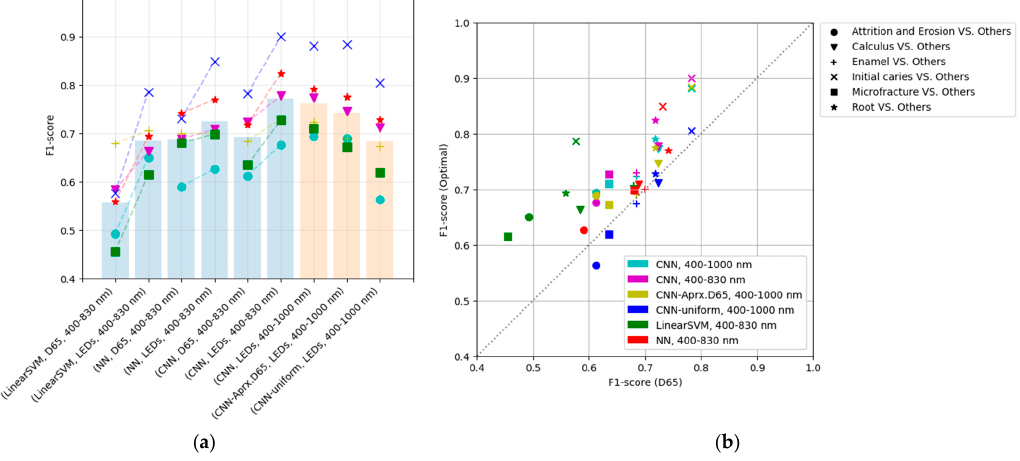
Figure 12. The performance of each method of the band-aligned SPD utilizing the NIR in the 400–1000 nm band with the proposed method with CNN: ( a ) F1-score for each method, and ( b ) compar- ison of performance between the reference (D65) and the optimal light. In the three models utilizing the 400–1000 nm band, the lighting weights were initialized in different ways: randomized in [0,1], approximating D65, and as uniform vector 1, respectively.